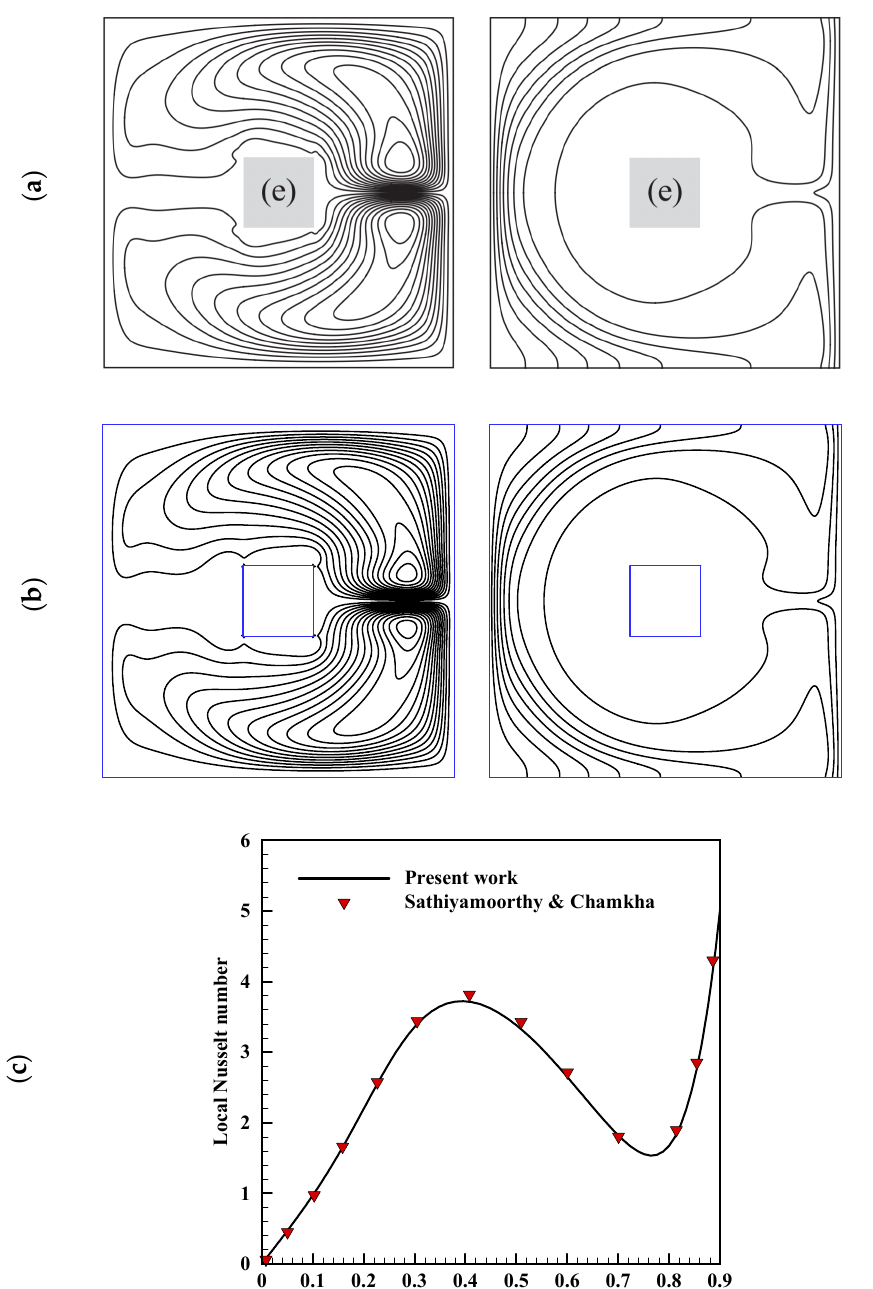
Figure 3. ( a , b ) Streamlines patterns (left column) and temperature (temperature) of Newtonian ferro- fluid; ( a ) Ashoori et al. [18] and ( b ) present investigation (Ra T = 0 , Ra M = 10 9 , Ma = 0, Pr = 1000, n = 1.0, l = 0.2, β c = 60 and ε = 5.0 ); ( c ) comparison of local average Nusselt number cal-